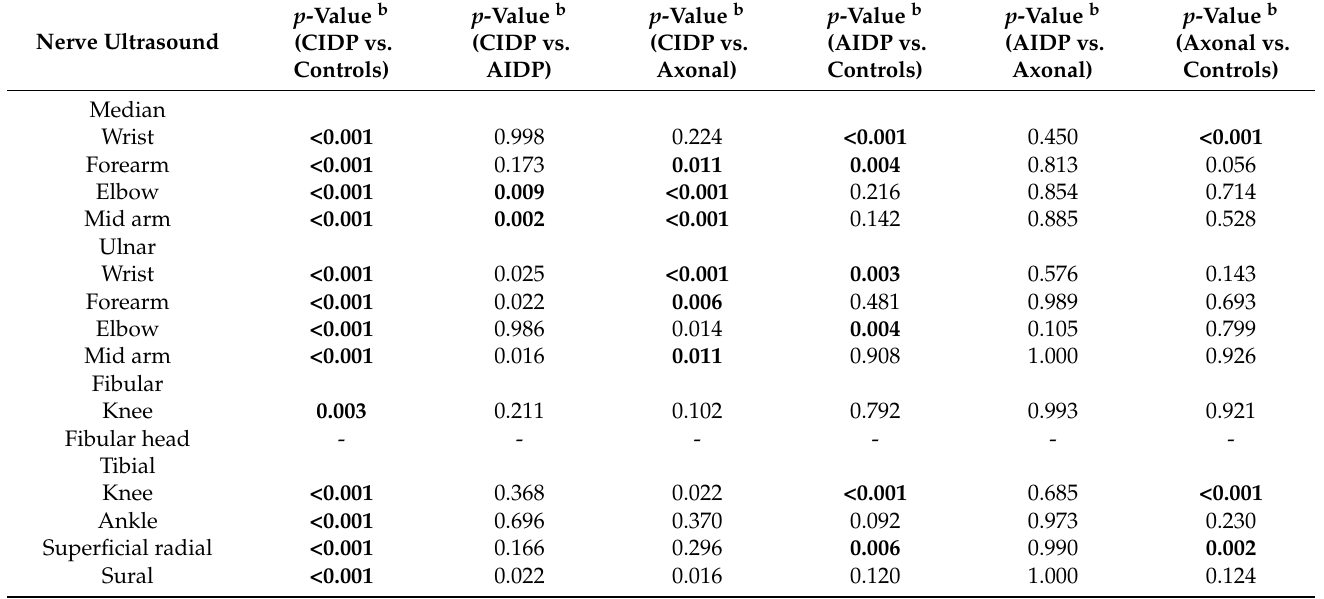
Table 3. Post-hoc